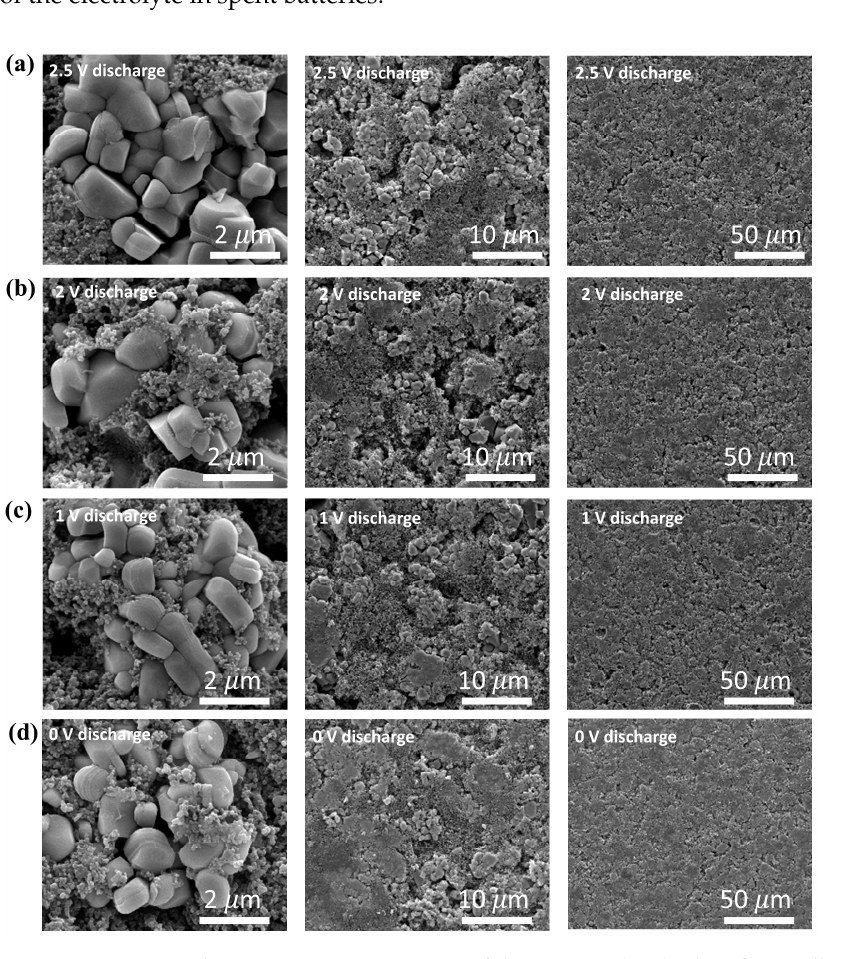
Figure 6. Scanning electron microscopy images of the recovered cathodes of LIB cell-2 discharged to different voltages: ( a ) 2.5 V, ( b ) 2 V, ( c ) 1 V, and ( d ) 0 V.